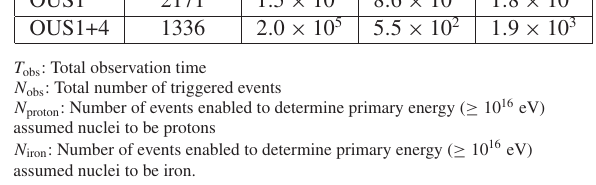
Figure 3. The simulated energy distributions in OUS1 (A) and OUS1+4 (B). Symbols of ( + ) and ( ∗ ) indicate proton primaries and iron ones, respectively.